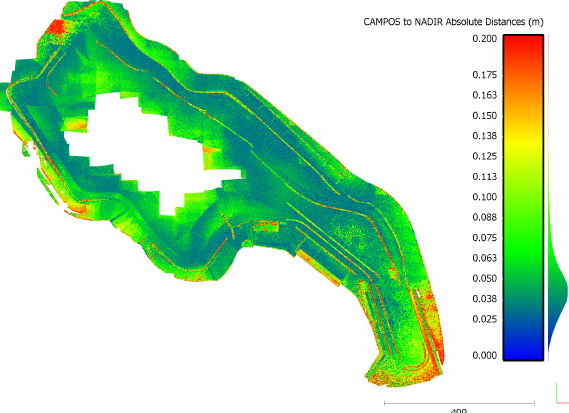
Figure 10. Distances between CAMPOS and nadir dense point